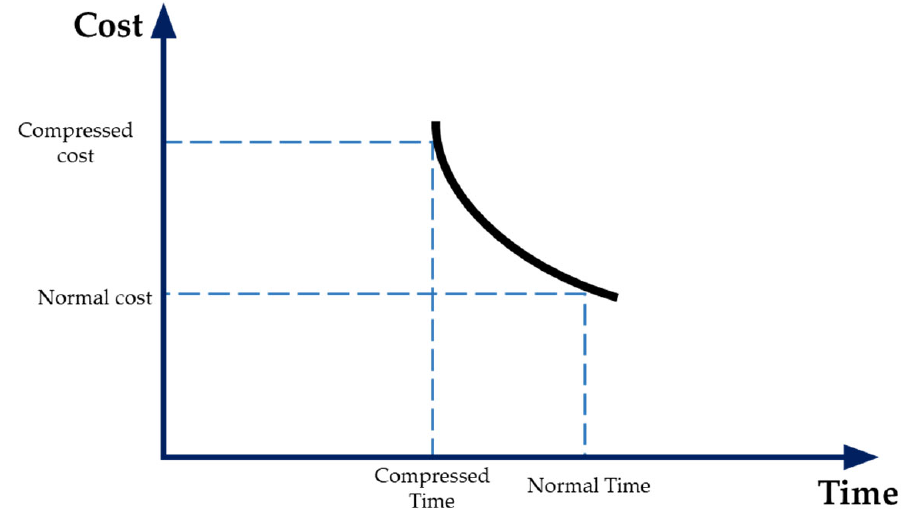
Figure 7. The trade ‐ off between cost and